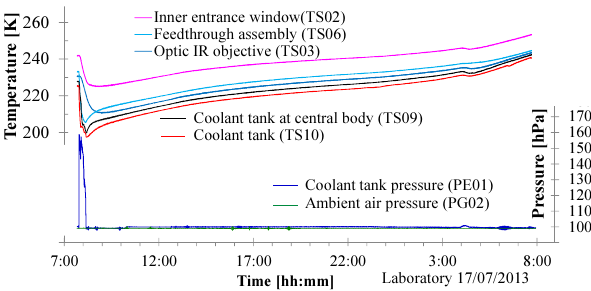
Figure 9. Spectrometer temperature and pressure values during lab- oratory testing of dry-ice filling (about 30min) followed by labora- tory operation without external coolant